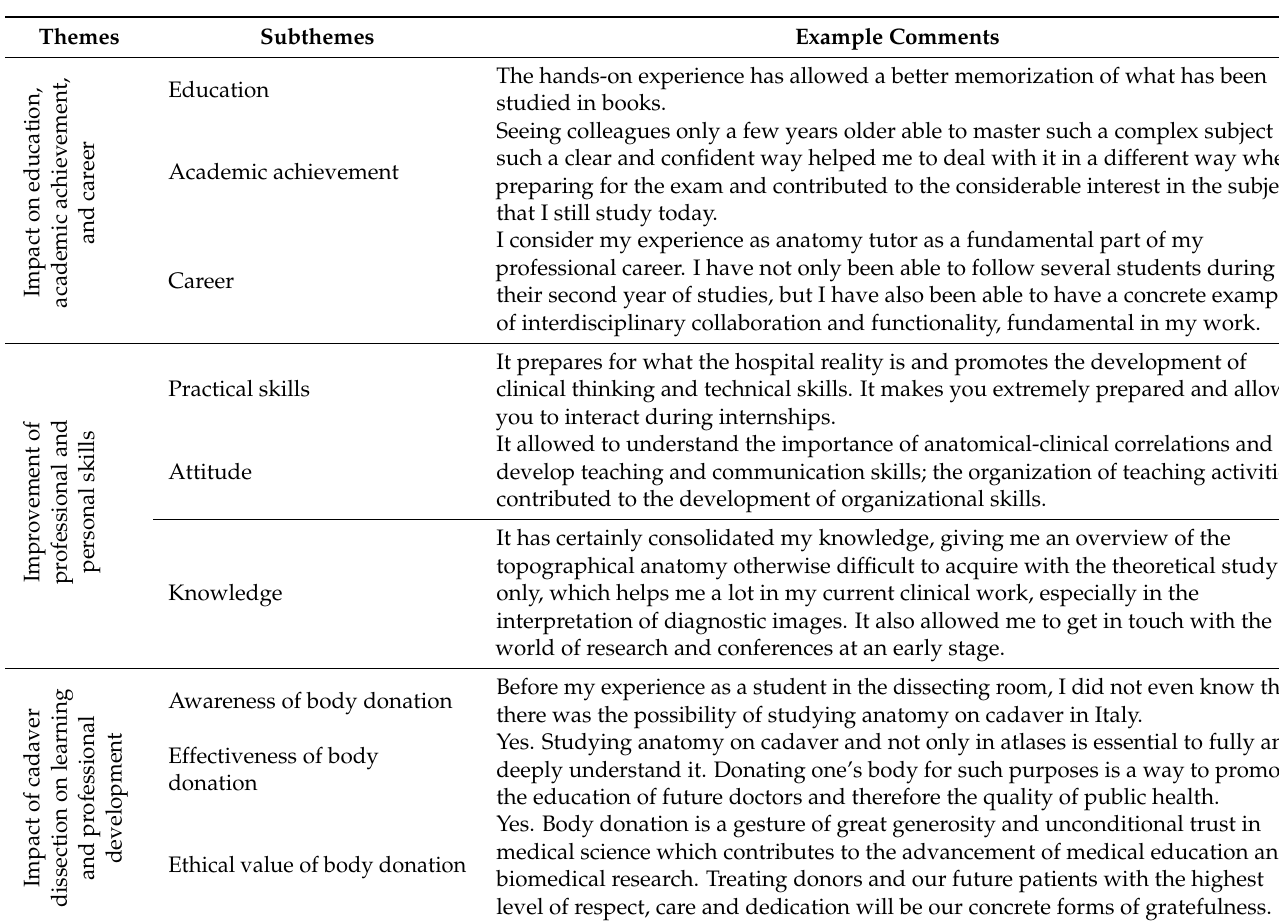
Table 2. Summary of the narrative comments grouped into themes and